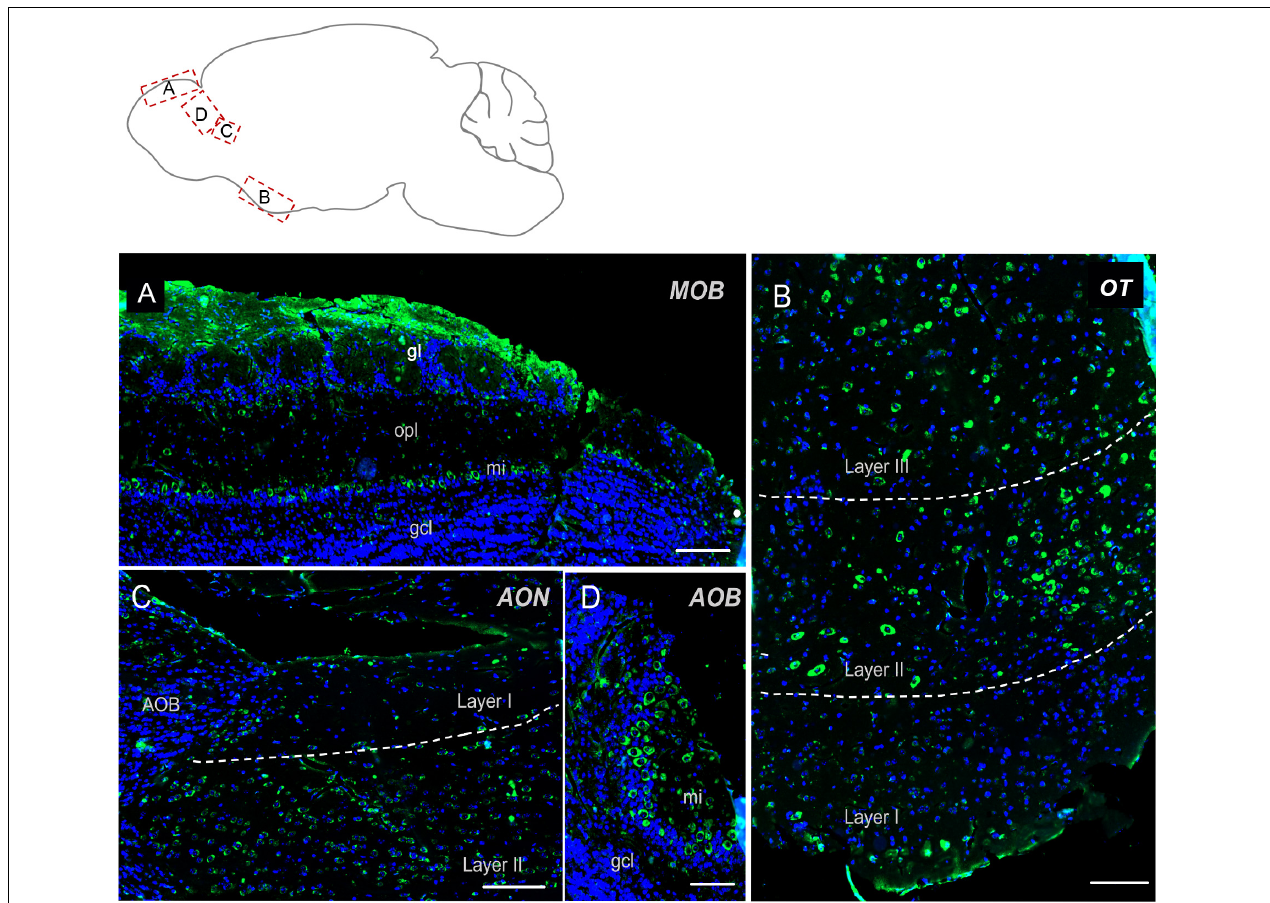
FIGURE 2 | Elovl5 distribution in olfactory regions. (A) In the olfactory bulb, immunohistochemical labeling for Elovl5 (green) and DAPI (blue), shows a strong signal in mitral cells (mi) and in the glomerular layer (gl), while cells belonging to the granule cell layer (gcl) are negative. (B) The olfactory tubercle (OT) (shown at high magnification) shows a predominant expression of Elovl5 (green) in layer II and layer III neurons. (C) In layer II neurons of the accessory olfactory nucleus (AON) a moderate presence of the enzyme is detected. (D) The accessory olfactory bulb shows a similar signal as the one detected in the main bulb, with a high intensity in mitral cells (mi) and no signal in the granule cell layer (gcl). MOB, Main Olfactory Bulb; mi, mitral cells; gl, glomerular layer; opl, outer plexiform layer; gcl, granular cell layer; OT, Olfactory Tubercle; AON, Anterior Olfatory Nucleus; AOB, Accessory Olfactory Bulb. Scalebars: (A,C) 200 µ m, (B) 100 µ m, and (D) 50 µ